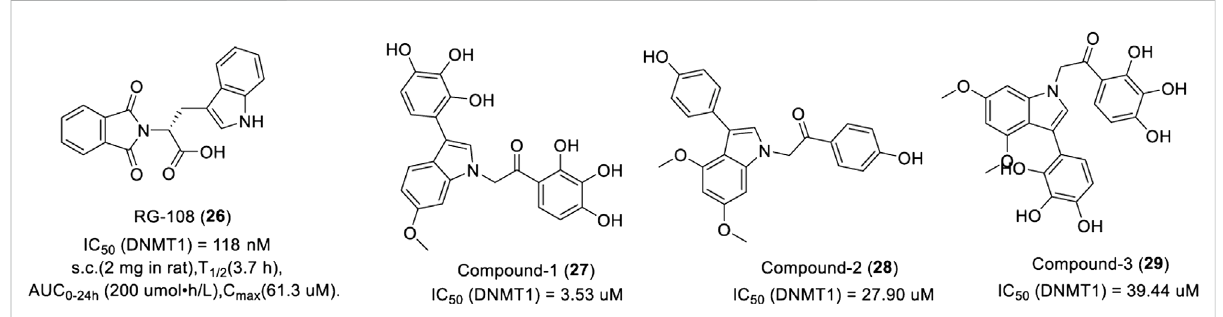
FIGURE 6 Chemical structure of indole-based DNMTis in preclinical.